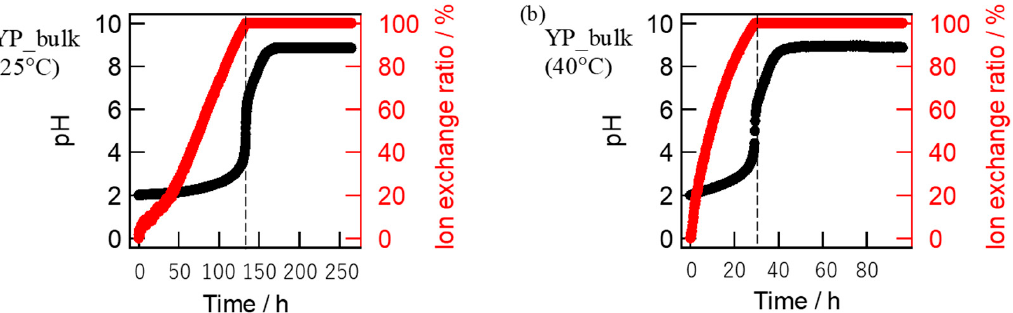
Figure 6. Time changes of pH values and Na + exchanged rates during ion exchange of Narpsio glass-ceramic bulks at the temperatures of 25 °C ( a ) and 40 °C ( b ).